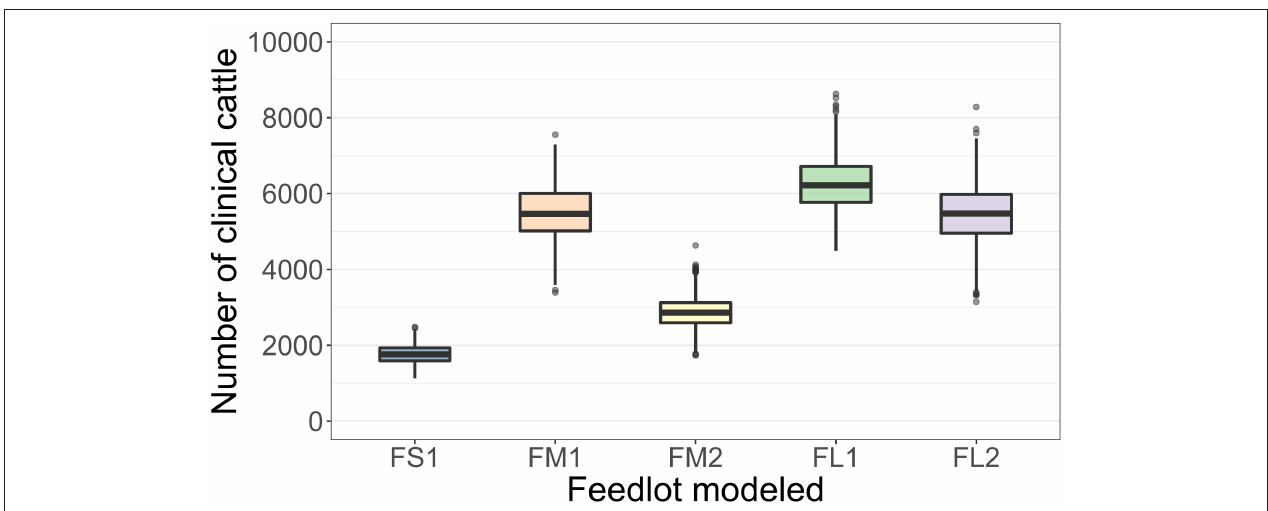
FIGURE 4 | Boxplot of the projected number of cattle with clinical FMD on the outbreak peak day for each of the feedlot size and layout cases modeled. The outbreak peak day was defined as the day with the highest number of clinical cattle (infectious and non-infectious) since the FMD introduction in each of n = 2,000 simulated outbreaks in the feedlot of that size and layout sampling the values of the target parameters. Feedlot size and layout cases modeled: FS1 is a 4,000 cattle feedlot with one hospital-pen; FM1 is a 12,000 cattle feedlot with one hospital-pen; FM2 is a 12,000 cattle feedlot with two hospital-pens; FL1 is a 24,000 feedlot with two hospital-pens; and FL2 is a 24,000 cattle feedlot with four hospital-pens (in all the layouts n = 200 cattle per home-pen).